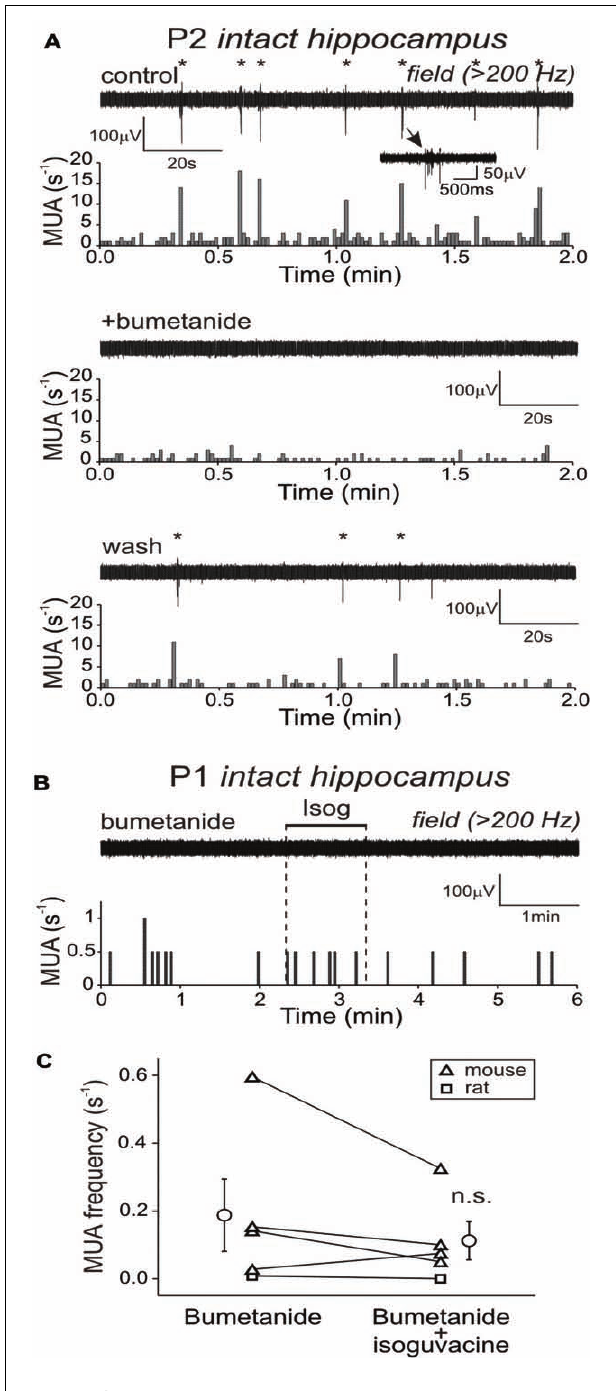
FIGURE 2 | Na + –K + –2Cl – co-transporter bumetanide blocks GDPs and prevents the excitatory effect of isoguvacine in the P1–3 intact hippocampus. (A) Field potential recordings of spontaneous network activity in P2 intact hippocampus in control, in the presence of 5 μ M bumetanide which blocked GDPs, and after washing out. (B) Example trace of MUA response on isoguvacine application in the presence of bumetanide (top) and corresponding histogram of MUA versus time (bottom). (C) Summary plot of MUA frequency in the presence of bumetanide and during isoguvacine application. Each pair of data points corresponds to individual intact hippocampus, open circles show mean values ±